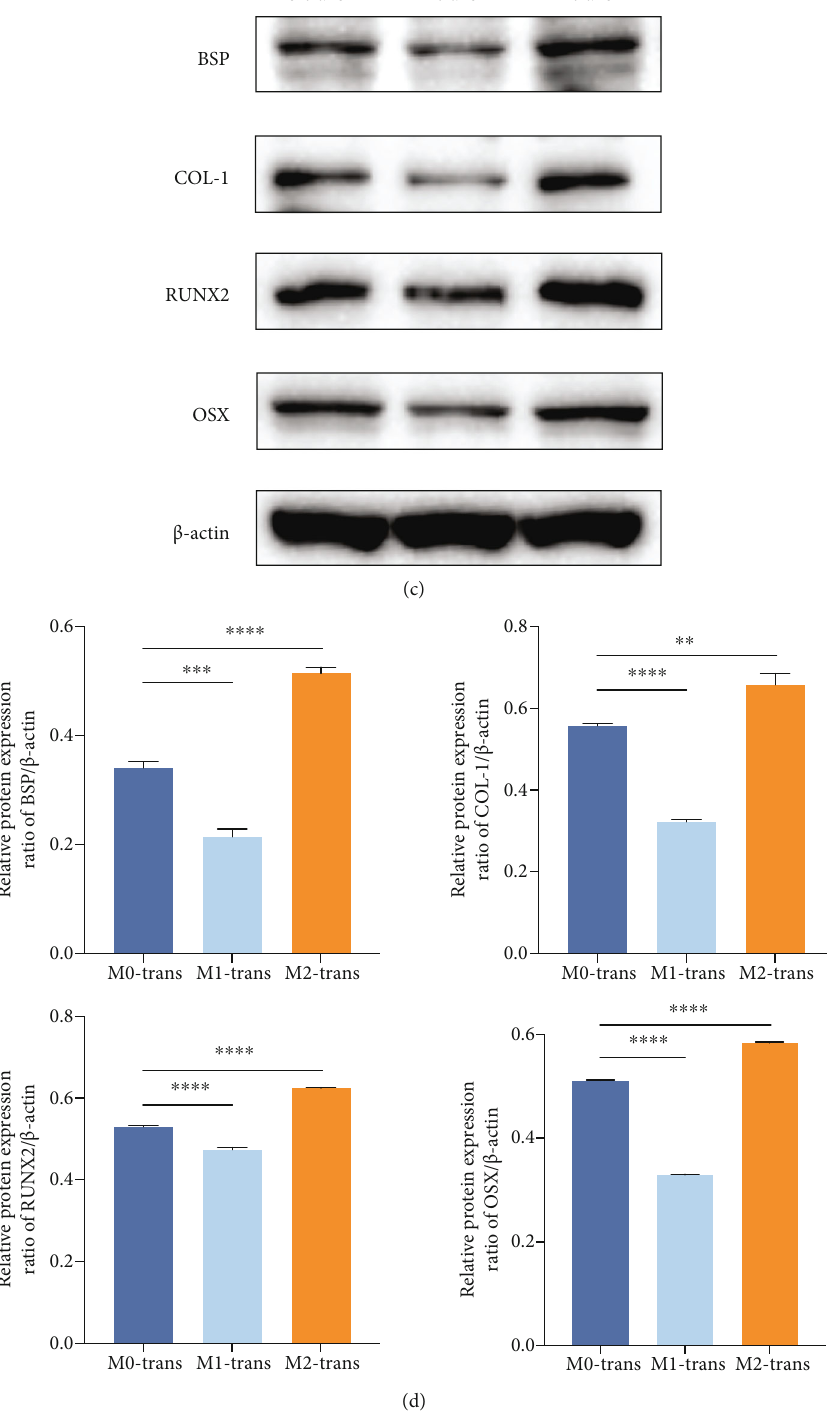
Figure 2: Macrophages with di ff erent polarization phenotypes in fl uenced cementoblast mineralization in the transwell coculture system. (a) Diagram of the transwell coculture system of cementoblasts and M0 and M1- and M2-polarized macrophages. (b) The mRNA expression levels of BSP, COL-1, RUNX2, OSX, and PTPLA in cementoblasts after a 3-day coculture with M0, M1, or M2 (referred to as M0-trans, M1- trans, and M2-trans). (c) Representative chemiluminescent images of BSP, COL-1, RUNX2, and OSX western blots from cementoblasts after a 3-day coculture with M0, M1, or M2 (referred to as M0-trans, M1-trans, and M2-trans). (d) Western blot analysis of BSP, COL-1, RUNX2, and OSX. The gray value was calibrated using β -actin. ∗ P < 0 : 05 , ∗∗ P < 0 : 01 , ∗∗∗ P < 0 : 001 , and ∗∗∗∗ P < 0 : 0001